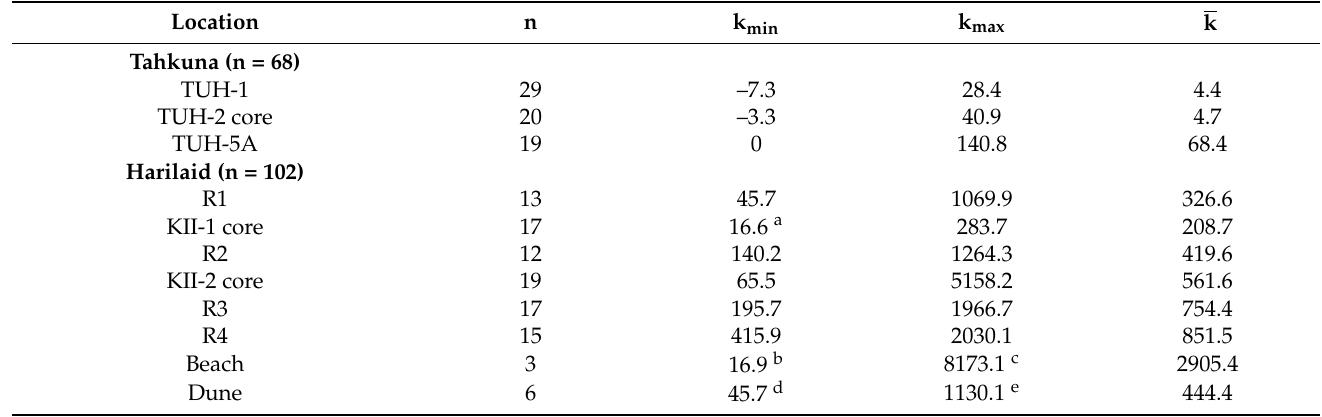
Table 1. Bulk low-field magnetic susceptibility ( κ , µ SI) values (minimum, maximum, and mean) of 170 sand samples from a suite of morphostratigraphic units and modern subenvironments (see Figure 1 for locations). The context of selected anomalous readings is indicated below, with the majority of MS maxima corresponding to visible heavy mineral concentrations. Note an increase in mean κ through time at Harilaid strandplain (R1 to R4). Buried organics at a 1.9 m depth in core KII-1 (a) yielded low MS values similar to those of the modern swash zones (b). The modern beach (wave-reworked) and dune (wind-transported) samples show that the aeolian ramp (e) along the western scarp (truncated ridge R1) derives its sediment from the HMC-rich upper berm (c). In contrast, the upper part of the scarp and dune top (d) have low values similar to the top of R1. n k